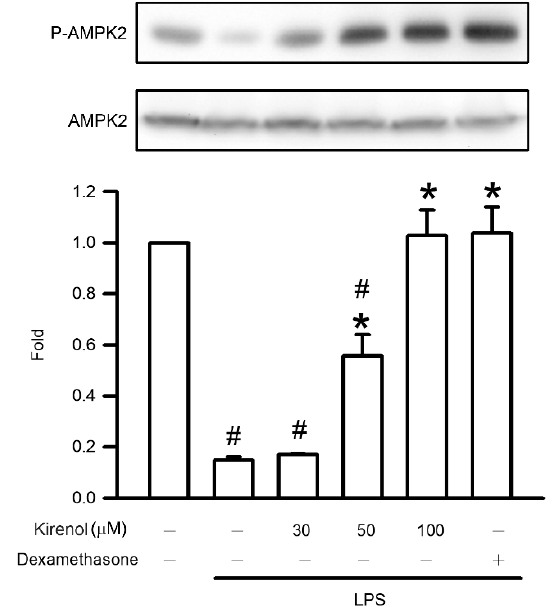
Figure 8. Kirenol attenuated the LPS-reduced the phosphorylation of AMPK2. The levels of AMPK2 phosphorylation in the lung tissues were analyzed by Western blotting analysis. Values are shown the mean ± S.D. of 3–4 mice per group. # represents the significant difference compared with the Group I ( p < 0.05); * represents the significant difference compared with Group II ( p < 0.05).